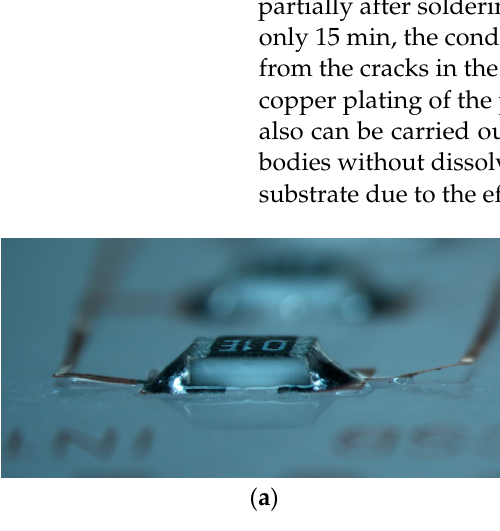
Figure 14. Soldering of 0603 SMD with SnBi solder at 180°C on aerosol jet printed Ag structures after electroless copper plating (substrate: Luxaprint 3D mold). Plating time 60 min ( a ) and 15 min ( b